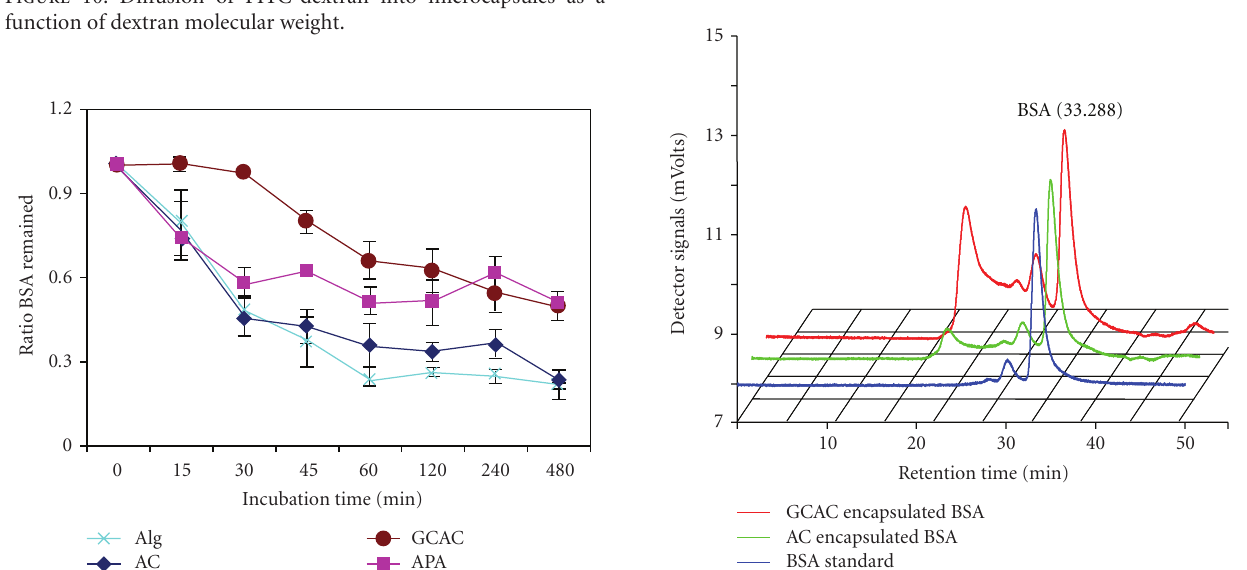
Figure 11: Penetration of BSA into microcapsules as a function of incubation time.